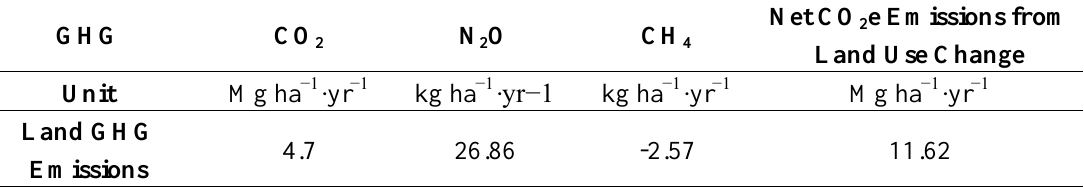
Table 4. Net CO e emissions from land use change under different GHG emission 2